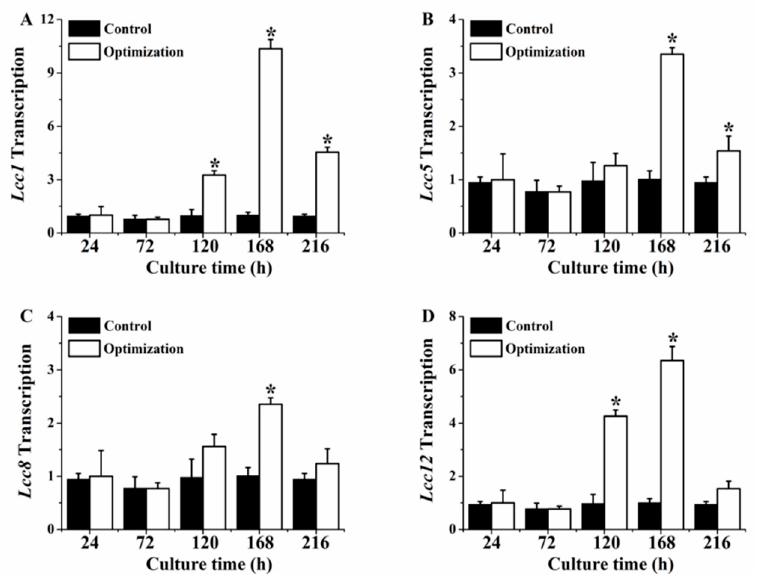
Figure 5. The transcriptional level of Lcc genes by P. eryngii -3 after optimization. ( A ) Lcc1 ; ( B ) Lcc5 ; ( C ) Lcc8 ; ( D ) Lcc12 . * Indicates statistical significance ( p < 0.05) compared to the control. Data points are the average of n = 3; error bars represent the standard error of the mean. The samples were harvested at 168 h of fermentation.